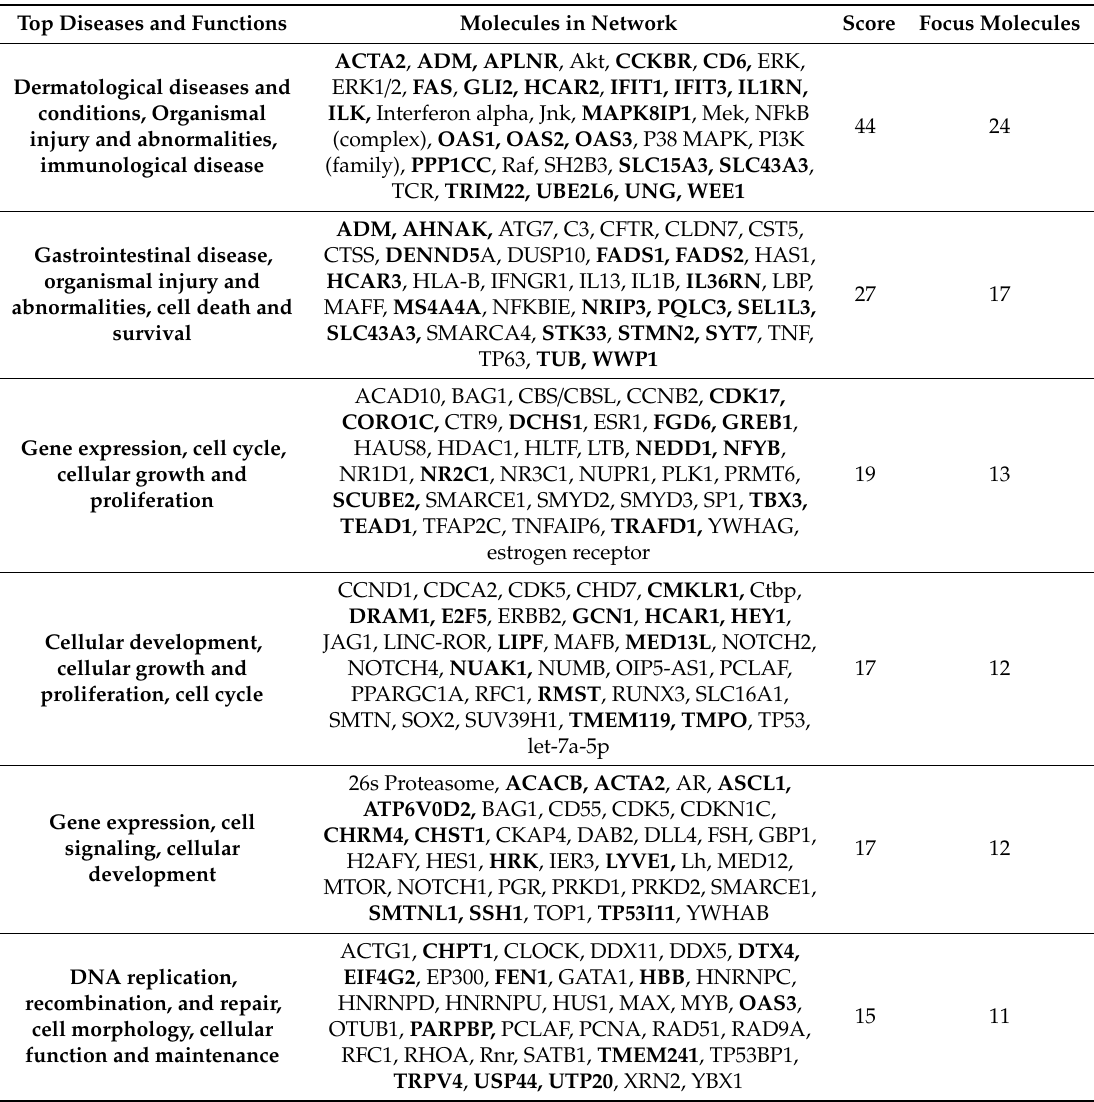
Table 3. Top regulatory networks identified by IPA. Genes detected in the TCGA-OV27 cohort are shown in